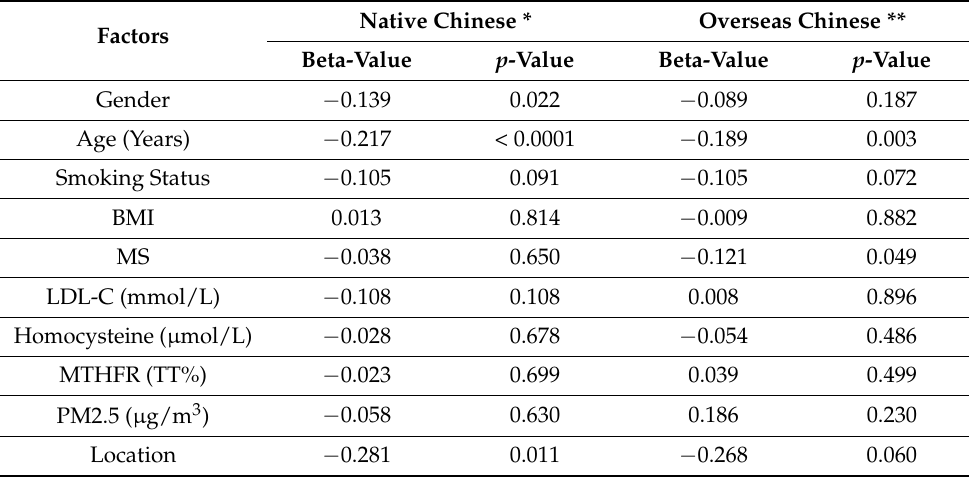
Table 6. Determinants of risk factors for brachial FMD in 1263 Chinese.